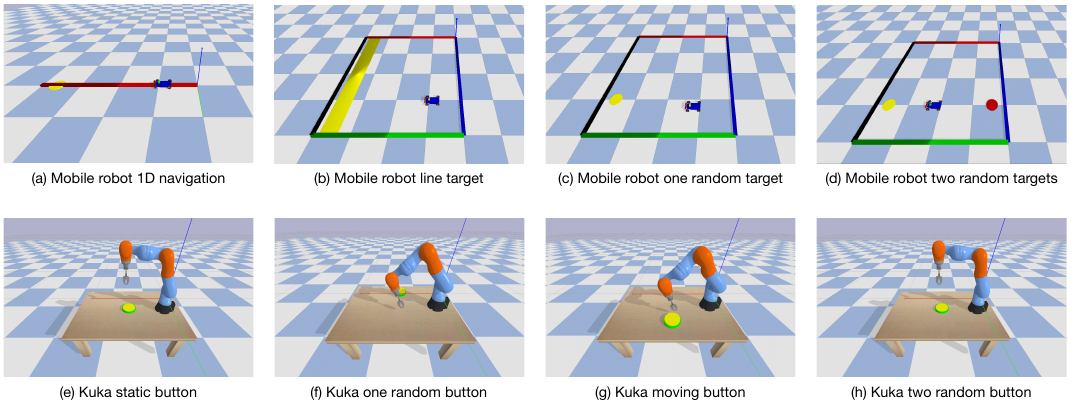
Figure 3. The Kuka robot arm tasks and mobile robot tasks adopted in this